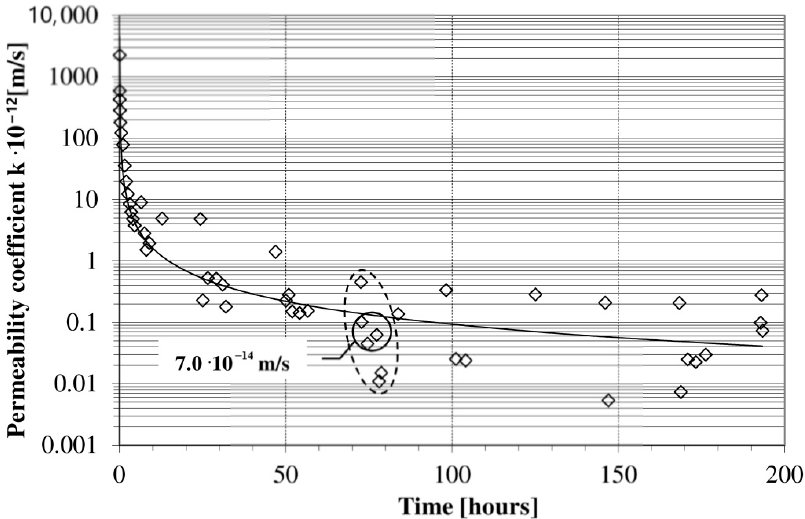
Figure 5. Typical permeability coefficient curve in time. Concrete with the A and B admixtures under a hydraulic pressure of 0.5 MPa.